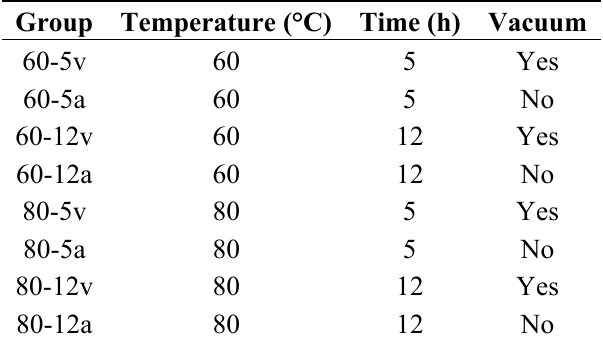
Table 2. Temperature, time and vacuum conditions used for cooking the pork cheeks of the different experimental groups considered in the